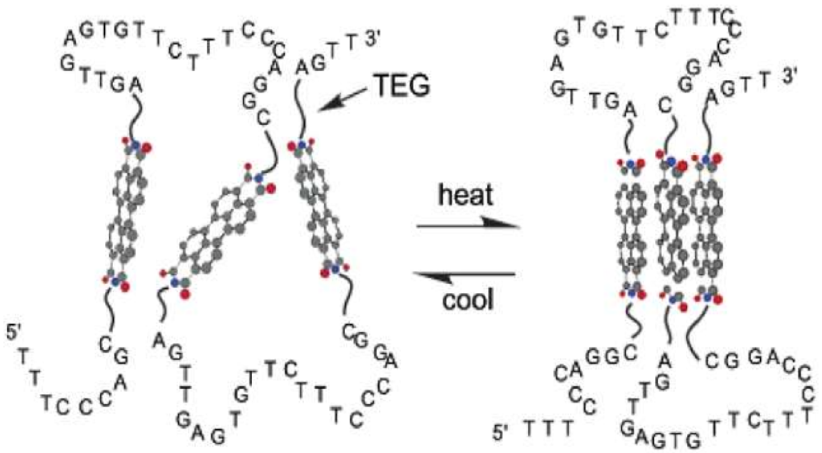
Figure 6. Thermophilic property of chromophoric DNA–perylene trimer, where TEG is a tetraethylene glycol [71]. Copyright © 2003, American Chemical